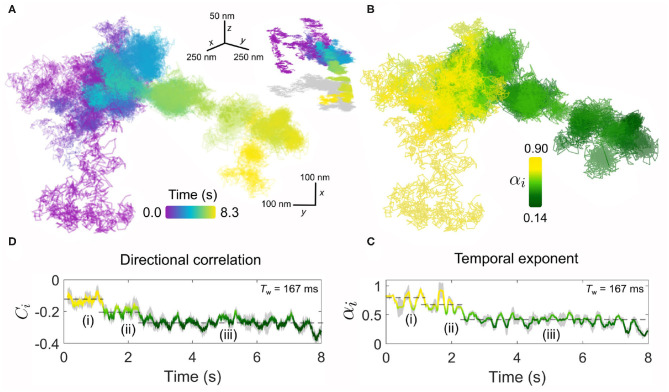
The endurance of iSPT imaging enables visualization of dynamic, time-evolving processes. (A) An exemplar trajectory of a EGFR-GNP on a HeLa cell is plotted for a measurement over 8.3 s recorded at 6,000 fps. Inset: the 3D trajectory of the x-y projection shown in (A), with a 2D “shadow” projection plotted in gray. (B) The temporal exponent of the trajectory presented in (A) plotted spatially over the trajectory positions. (C) Temporal exponent plotted as an explicit function of time. (D) The corresponding directional correlation of the trajectory is also plotted as a function of time. Both temporal exponent and directional correlation use a sliding window of 1,000 frames (Tw = 167 ms) and the dashed lines guide the eye to the three distinct phases of diffusive behavior, labeled (i)–(iii).